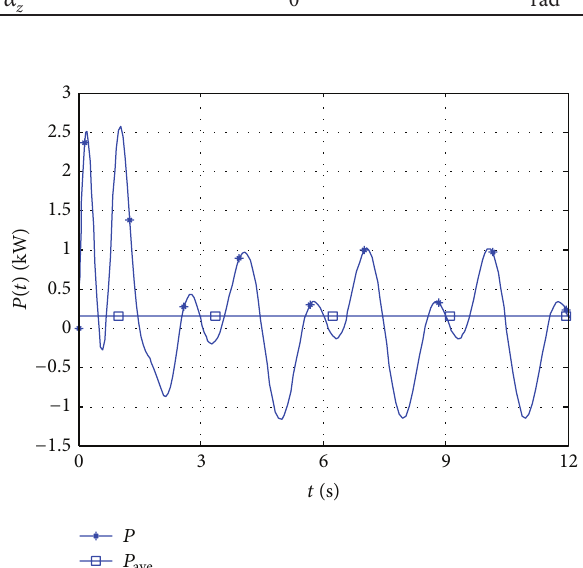
Figure 8: Heave motions of the tensegrity-based water wave energy